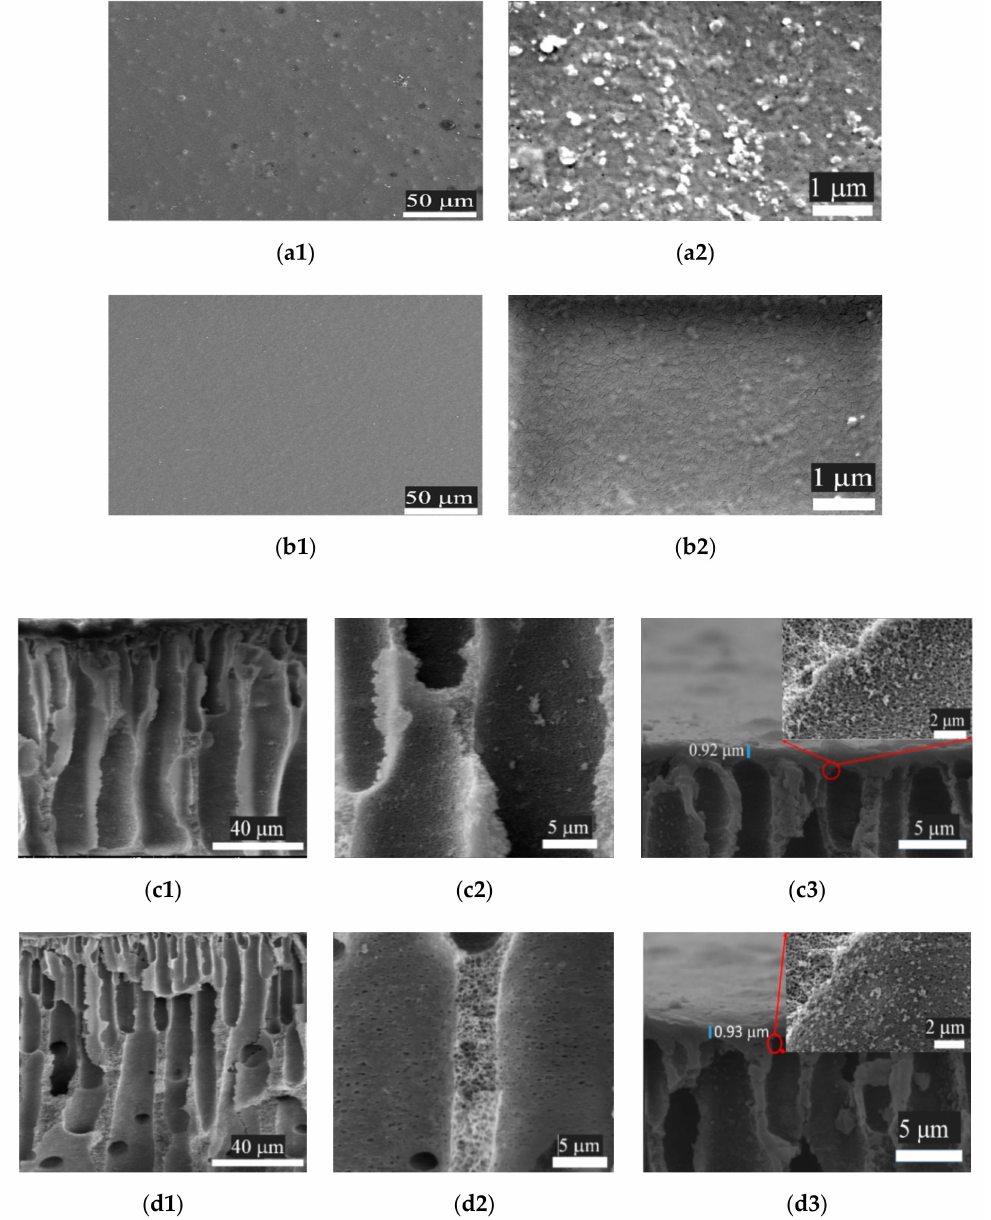
Figure 6. Scanning electron microscopy (SEM) images of the CA-DMSO (CAD) membrane ( a1 , a2 , c1 – c3 ) and the CA-DMSO / acetone (CADA) membrane ( b1 , b2 , d1 – d3